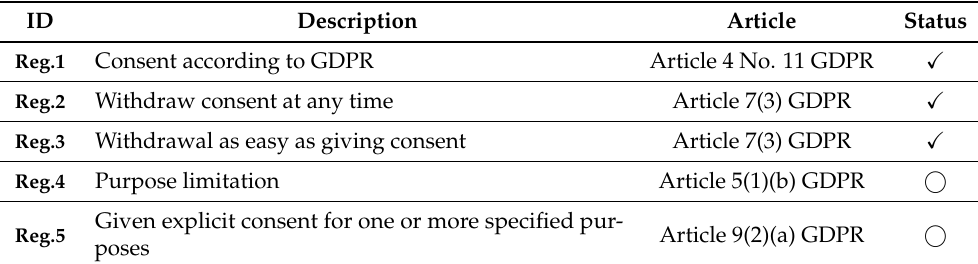
Table 6. Evaluation of compliance with